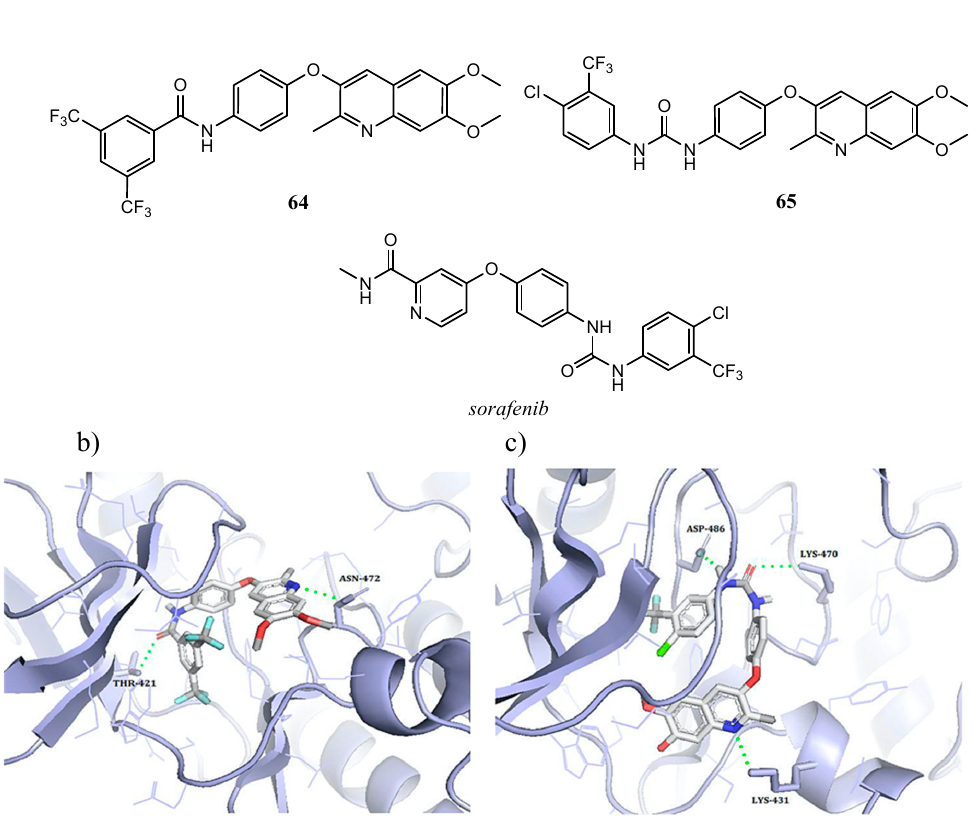
Figure 35. ( a ) Structures of diarylurea derivative sorafenib and of quinoline inhibitors 64,65 as selective inhibitors of Raf . ; ( b ) The best docked pose of 64 within the C-Raf active site (two H-bond stabilize the ligand-protein complex: amidic carbonyl oxygen-Thr 421 , quinolinyl nitrogen-Asn 472 ); ( c ) best docked pose for 65 in C-Raf active site (three H-bond stabilize the interaction: urea carbonyl oxygen-catalytic Lys 470 , urea terminal nitrogen-Asp 486 , quinolinyl nitrogen-Lys 431 ) [139,140]. El-Damasy et al. designed and synthetized several quinoline analogues of sorafenib, substituting the central phenoxy nucleus with a quinoline one and inserting the two recurrent moieties of the lead compound, the arylurea/arylamide and the N-methyl picolinamide, respectively at the C-2 and C-5 positions of the quinoline ring system.